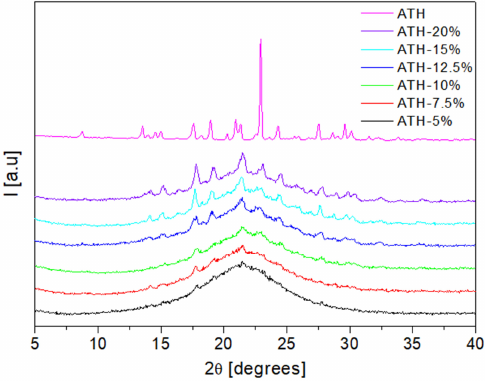
Figure 6. The X-ray powder diffraction (XRPD) patterns of raw unprocessed ATH and fabricated tablets. 2.7. Polarized Light Microscopy Polarized light microscopy was used for crystal identification as well as for the ob- servation of a cross section of the inner structure of fabricated tablets before and after the performance of dissolution testing. As shown in Figure 7, crystals are present on the cross section of tablets prepared with different amounts of ATH (5–20%).